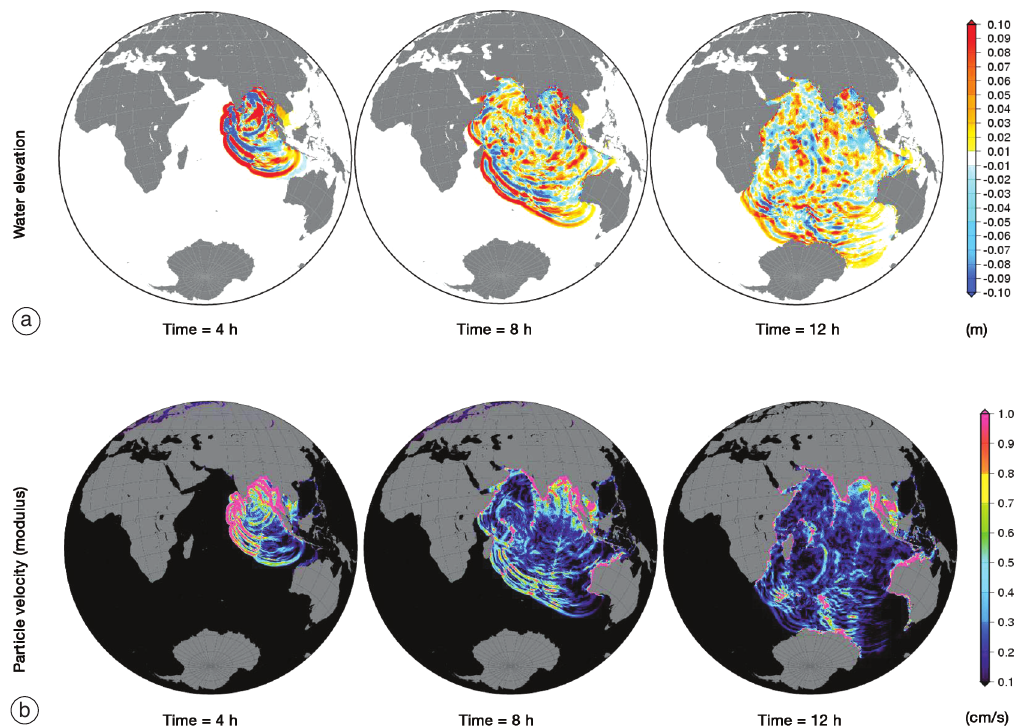
Fig. 1a,b. Snapshots of the propagating tsunami taken at 4 h interval show a) the water elevation, b) the mod- ulus of the particle